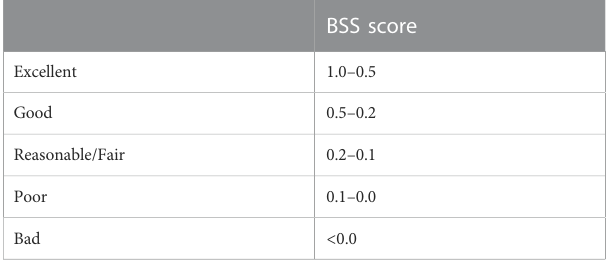
TABLE 3 Classi fi cation of model performance according to Sutherland et al. (2004) for the BSS based on Mean square error (Equation